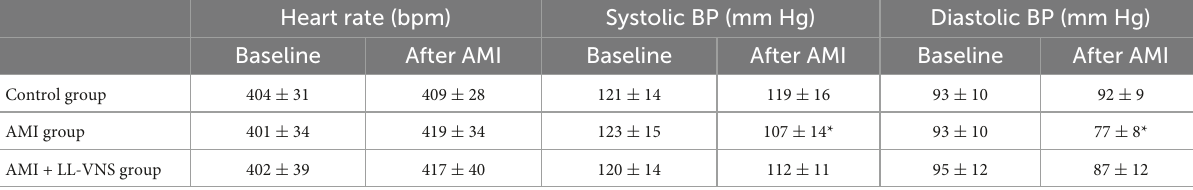
TABLE 1 Effects of low-level vagus nerve stimulation (LL-VNS) on physiological parameters.